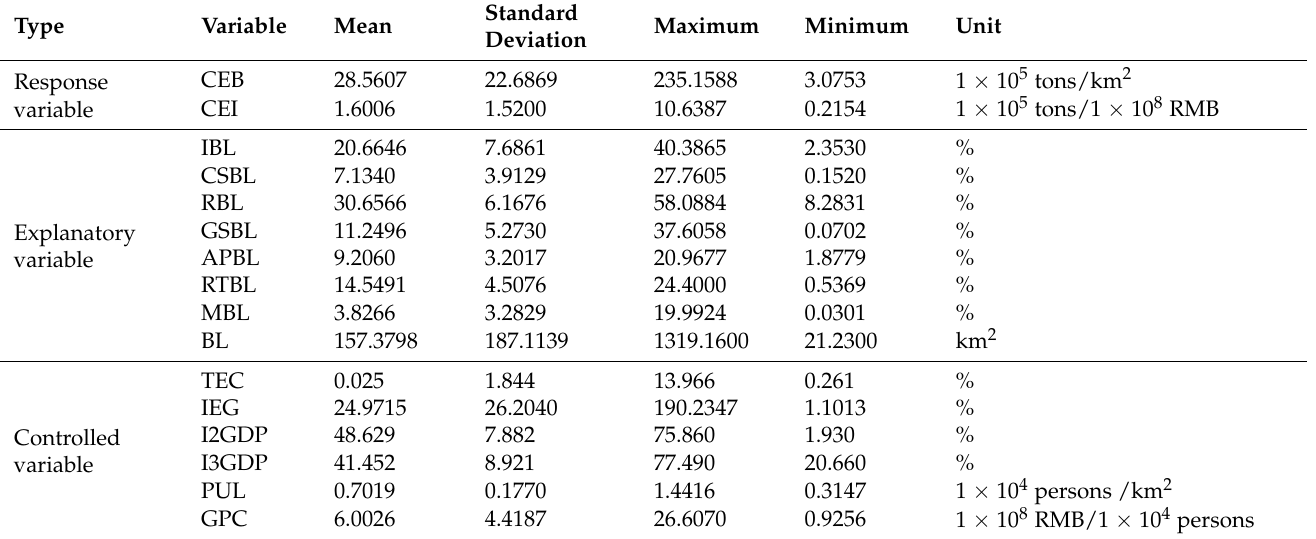
Table 1. Descriptive statistics of the